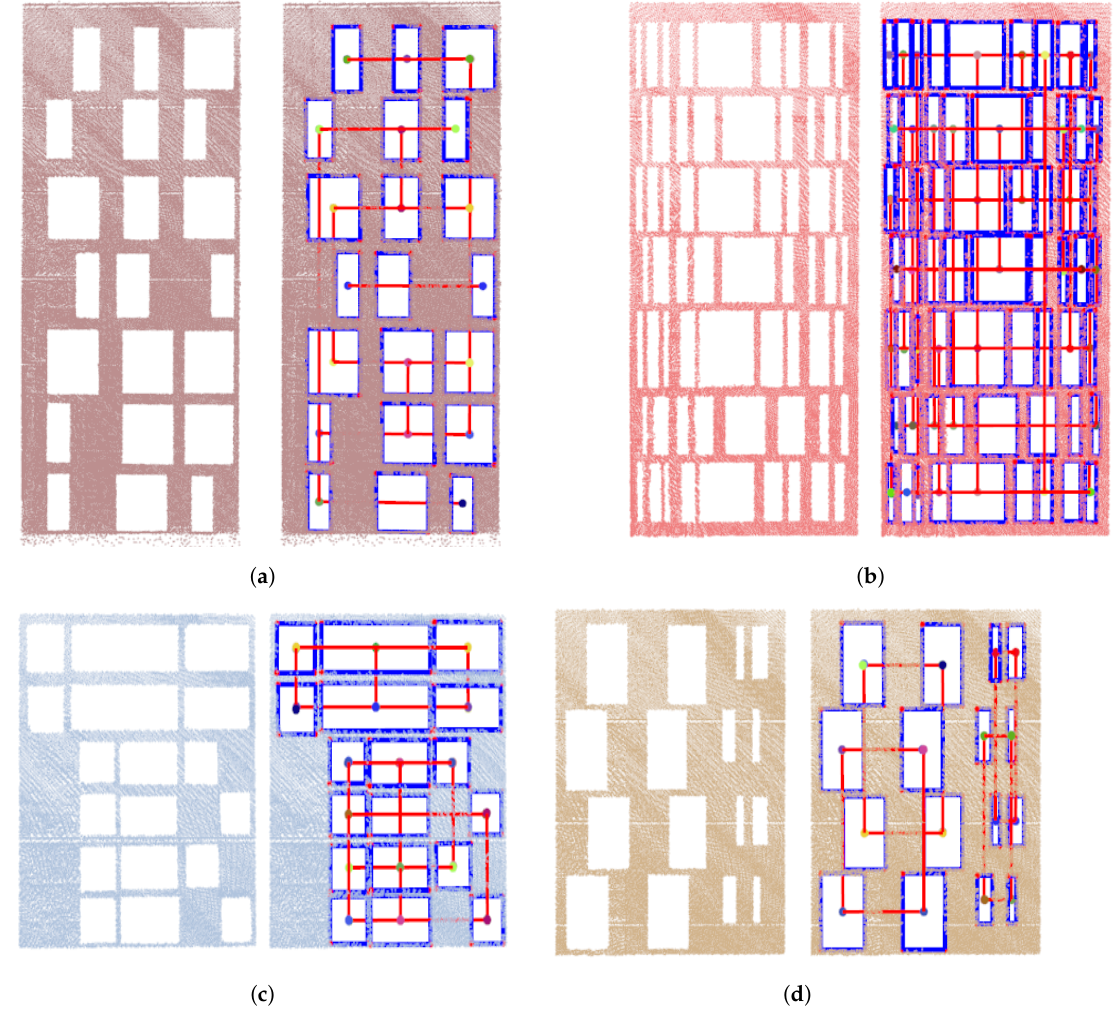
Figure 7. The synthetic point cloud and detected alignments for the synthetic data ( a – d ). Left in each subfigure ( a – d ) is the synthetic point cloud created according to the reference image in Figure 6 a – d . The right shows the reconstruction (blue frames) and association (red lines with endpoints in specific colors representing the relationship of entities) of facade